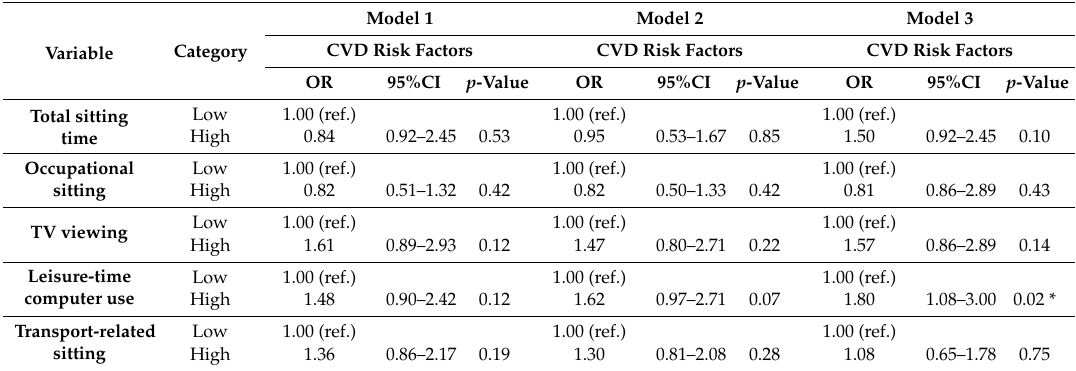
Table 4. Summary of the logistic regression analysis of time spent engaged in sedentary behavior and cardiovascular disease risk